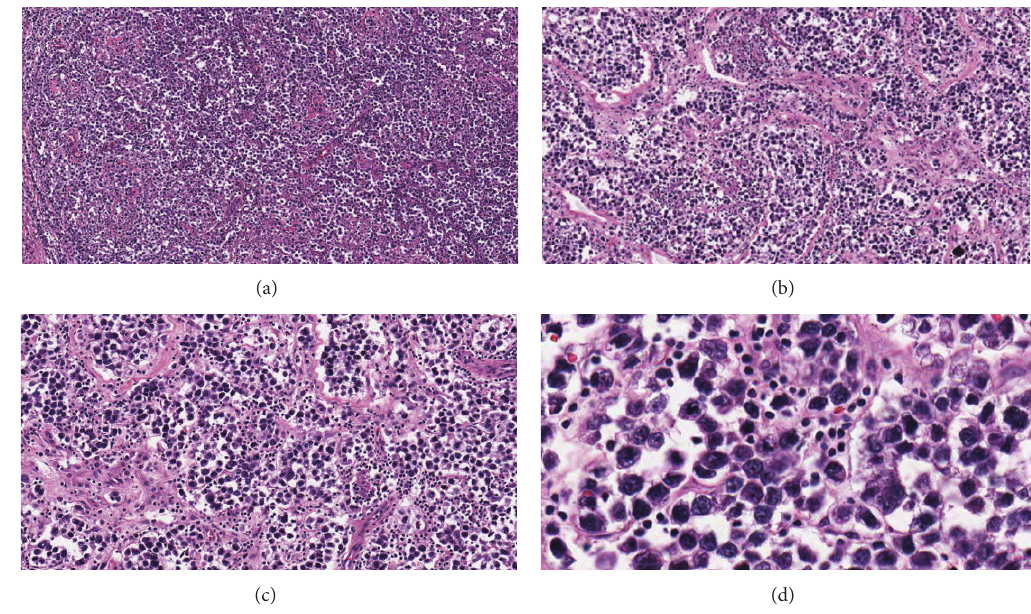
Figure 2: Surgical pathology. (a) Right testicle low power 4x, (b) left testicle low-power 4x, (c) 10x, and (d) 20x.